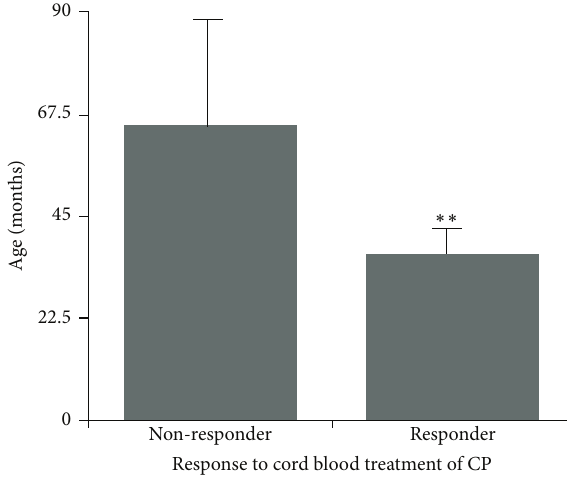
Figure 10: 4.5-year follow-up. The boy (L. B.) has now entered primary school at the age of 7 and 4.5 years after transplantation of autologous cord blood after global hypoxic-ischemic brain damage caused by cardiac arrest followed by a quadriplegic persistent vege- tative state. He is still using a posterior gait trainer for ambulation. (Follow-up at 2 years see video S5, S6 in Supplementary Material [44]).